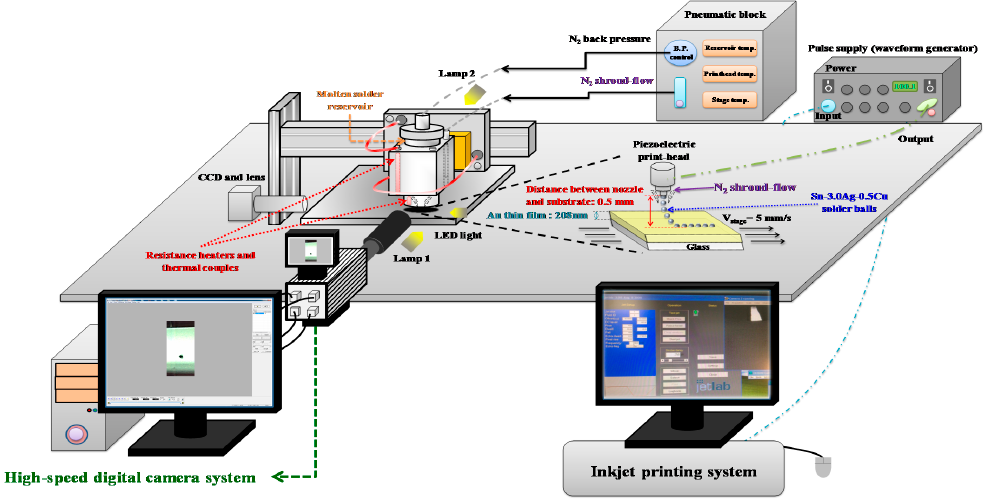
Figure 1. Schematic diagram of the experimental apparatus for the molten metal deposition and